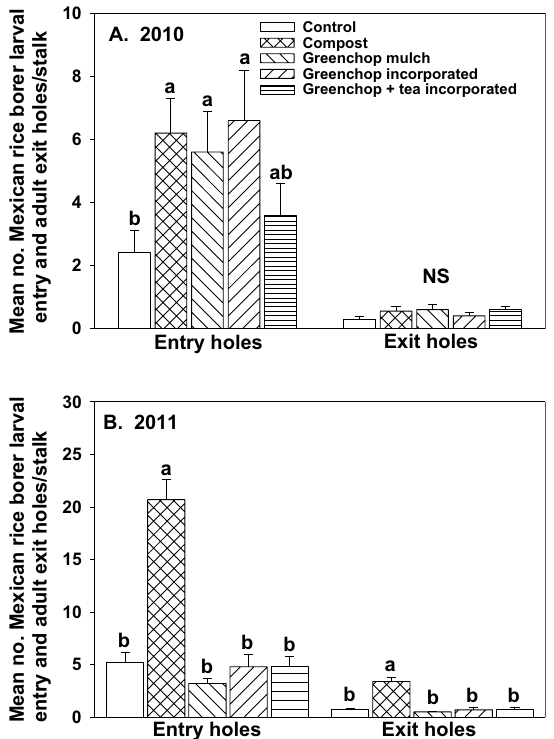
Fig. 1 Mean ( SE) numbers of E. loftini entry and exit holes per stalk ± from field plot soil amended with compost, and greenchop that was mulched, soil incorporated, and sprayed with compost extract before soil incorporation, and a non-amended control, based on 15 stalks/ plot ( n 6 plots), Hidalgo Co., Texas; A, 2010; B, 2011 =